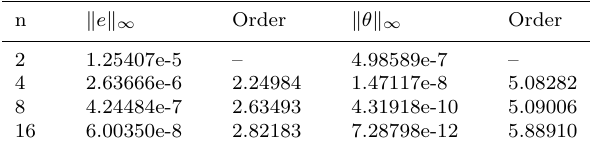
Table 6. Numerical results for example